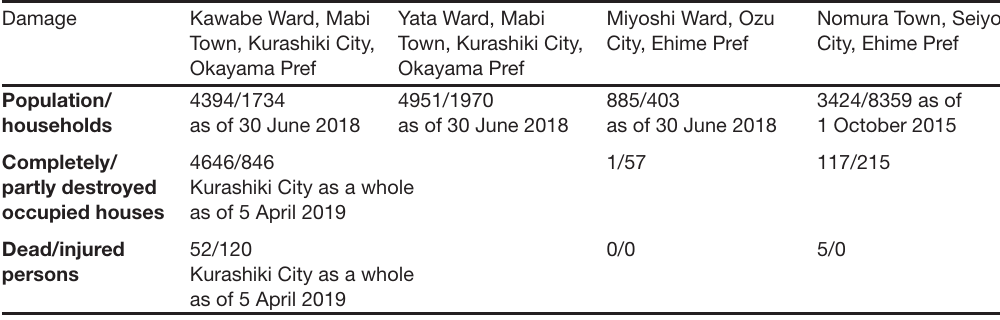
Table 3. Damage of the 2018 disaster in field sites